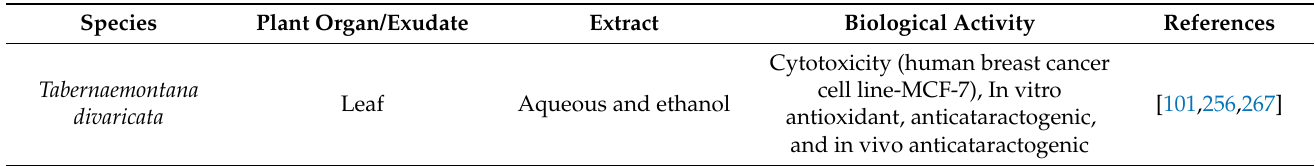
Table 10. Biological activity of synthesized silver nanoparticles using extracts isolated from Tabernaemontana species. Species Plant